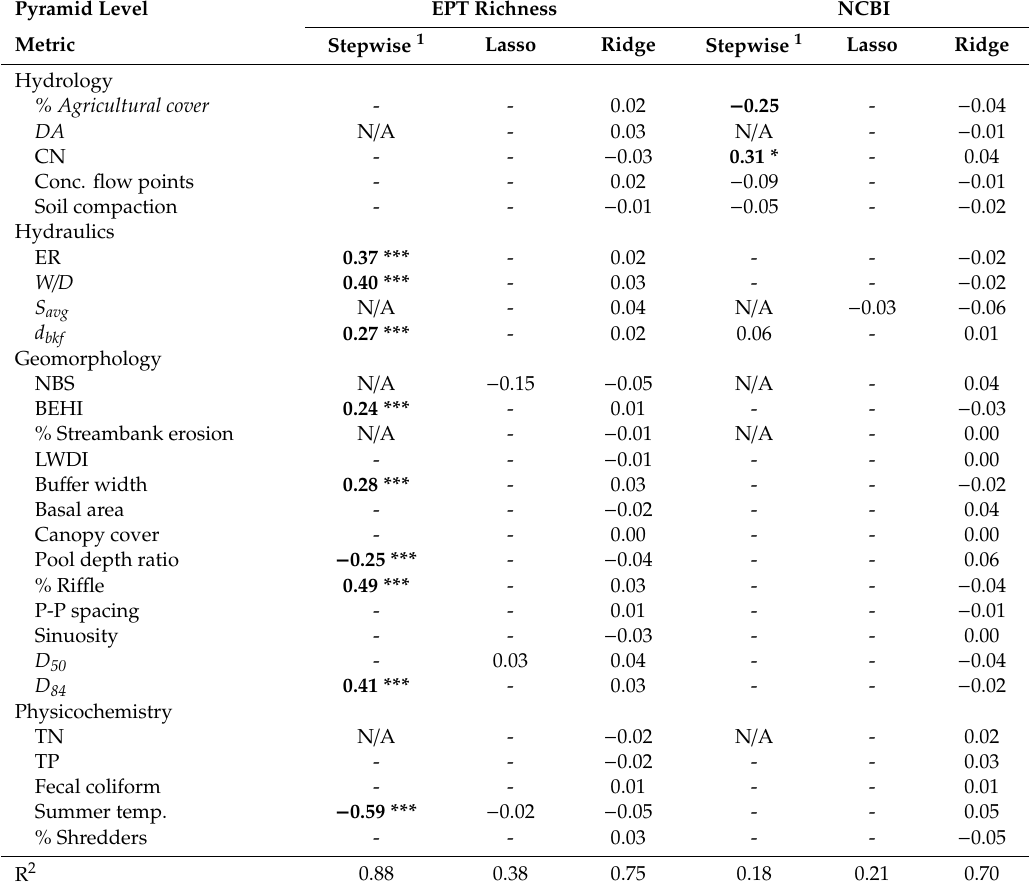
Table 4. Partial regression coe ffi cients resulting from stepwise, lasso, and ridge with reduced SQT + datasets for EPT richness and the NCBI. Variables with higher weights are in bold ( ≥ | 0.20 | ). Stepwise was run on the reduced dataset (22 predictors, n = 34). Lasso and ridge were run on the reduced dataset (27 predictors, n = 34). Variables removed from all six models and not listed in the table include: % developed, forested, and impervious cover; bankfull width; bankfull area; BHR; and specific conductivity. N / A indicates that the variable was removed from the model to address multicollinearity and / or dimension reduction. Italicized variables are additional variables, not included in the SQT protocol. Asterisks correspond to values that are statistically significant at applicable alpha levels for stepwise (see below